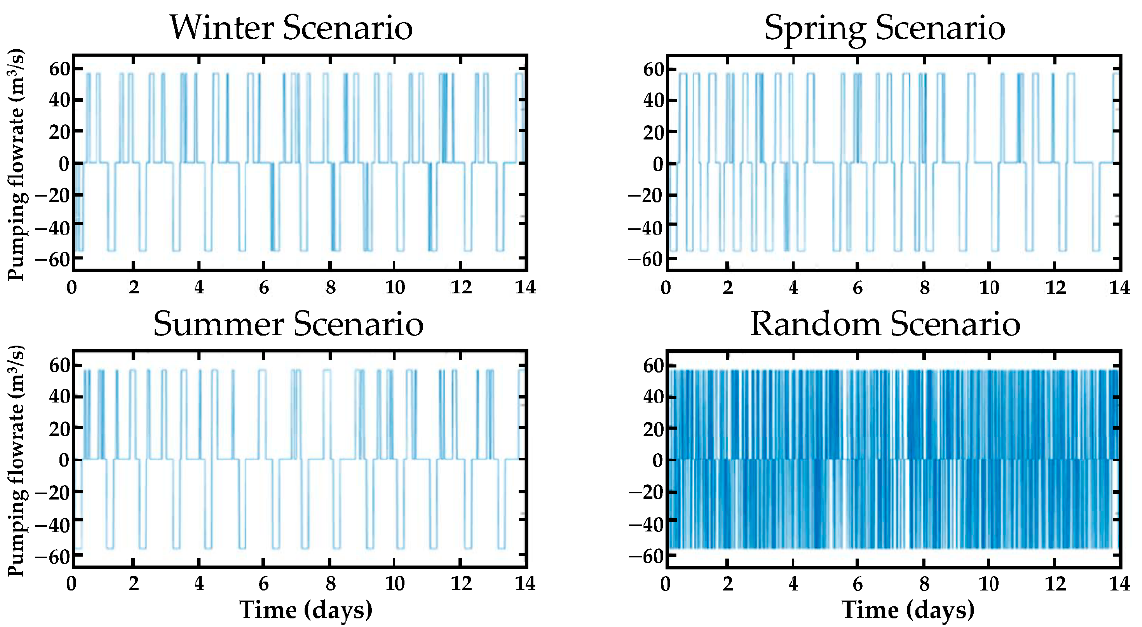
Figure 4. Pumping-discharge scenarios developed and used as inputs to the numerical flow model. Negative flow rate values correspond to pumping operations in the quarry and filling of the upper reservoir. Positive flow rate values correspond to discharge steps of the upper reservoir through the turbines and injection in the quarry.